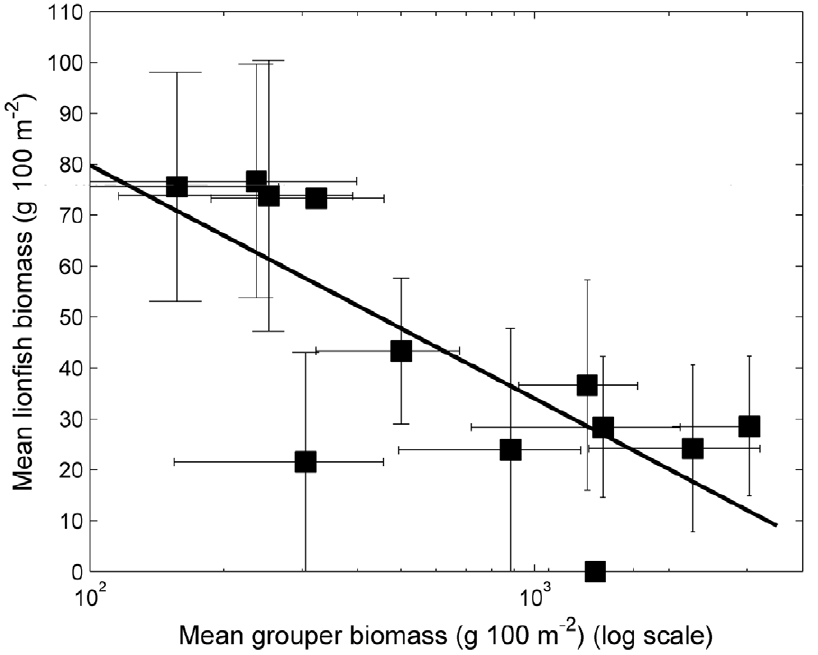
Figure 2. Relationship between grouper biomass and lionfish density. Open squares are sites outside the Exuma Cays Land and Sea Park, filled squares are sites within the Park. Errors bars represent standard error.